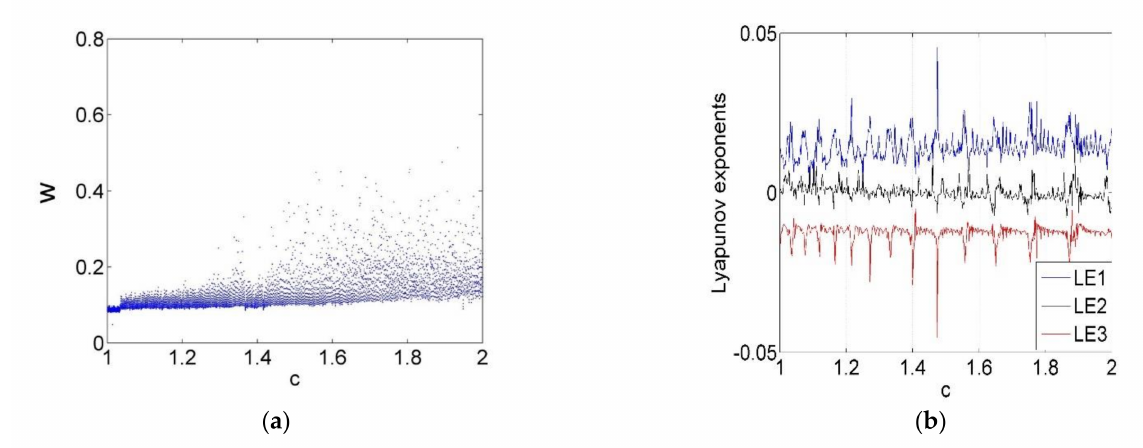
Figure 7. Dynamic study of the chaotic system (4) with ( a , b ) = ( 14,0.5 ) : ( a ) The bifurcation diagram with respect to c and ( b ) The Lyapunov exponents spectrum. Figure 7 also signifies robust chaos in the system (4) in the whole bifurcation